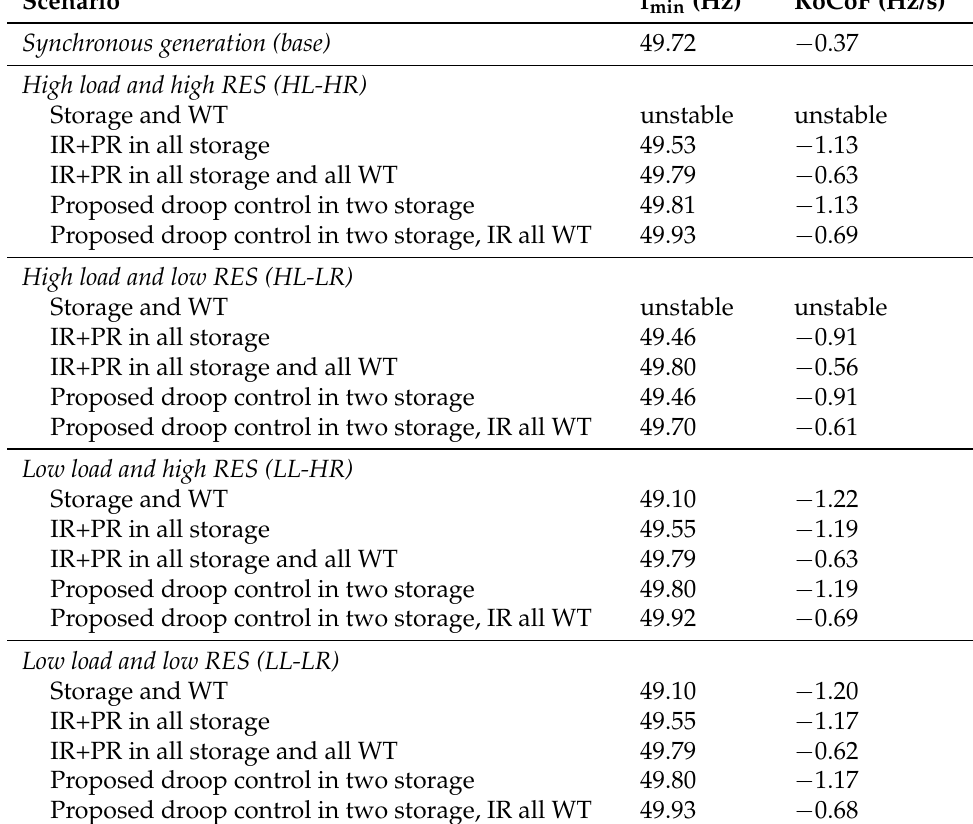
Table 3. Table summary of the simulation results with frequency